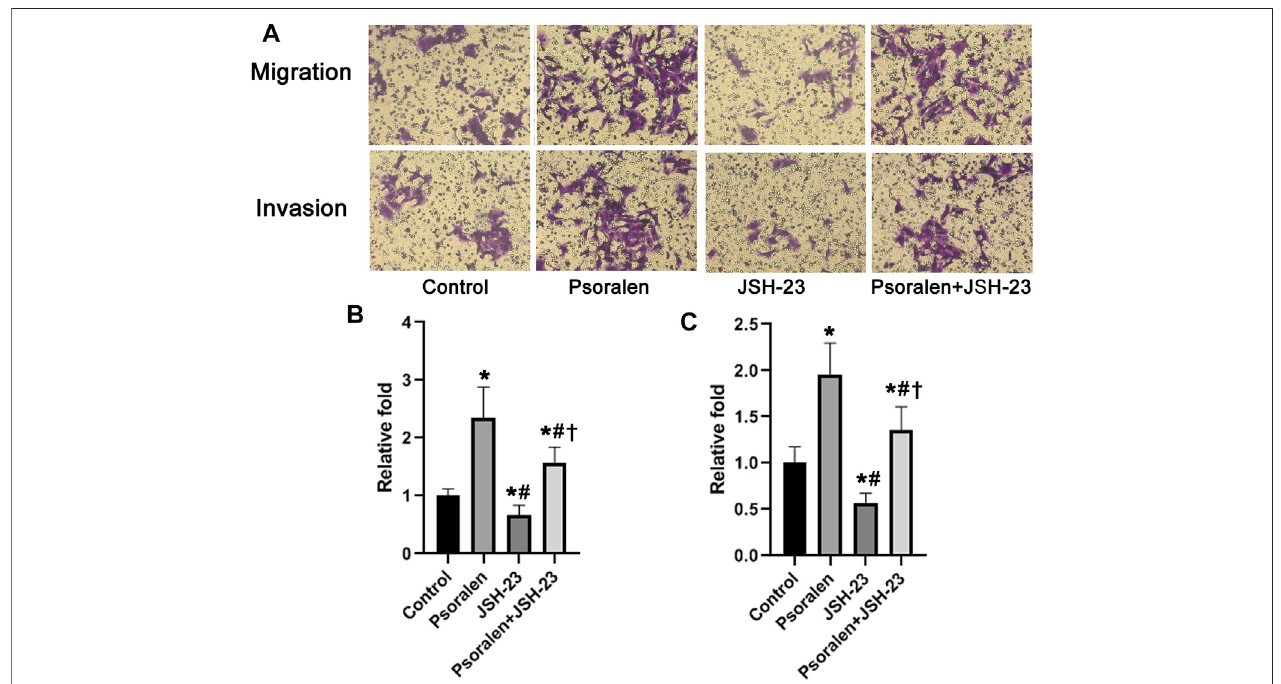
FIGURE 5 | Involvement of NF- κ B in psoralen-induced enhancement of cell invasiveness analyzed by Transwell assay. (A) Representative images of Transwell assayofHTR-8/SVneocellsafterexposuretopsoralen(0.5 μ mol/L),JSH-23(10 μ mol/L)aloneorincombinationfor24 h. (B) Changesinthenumberofmigratingcellsin relation to control cells. (C) Changes in the number of invading cells in relation to control cells. Values are mean ± SD. * p < 0.05 vs. control; # p < 0.05 vs. psoralen; † p < 0.05 vs.